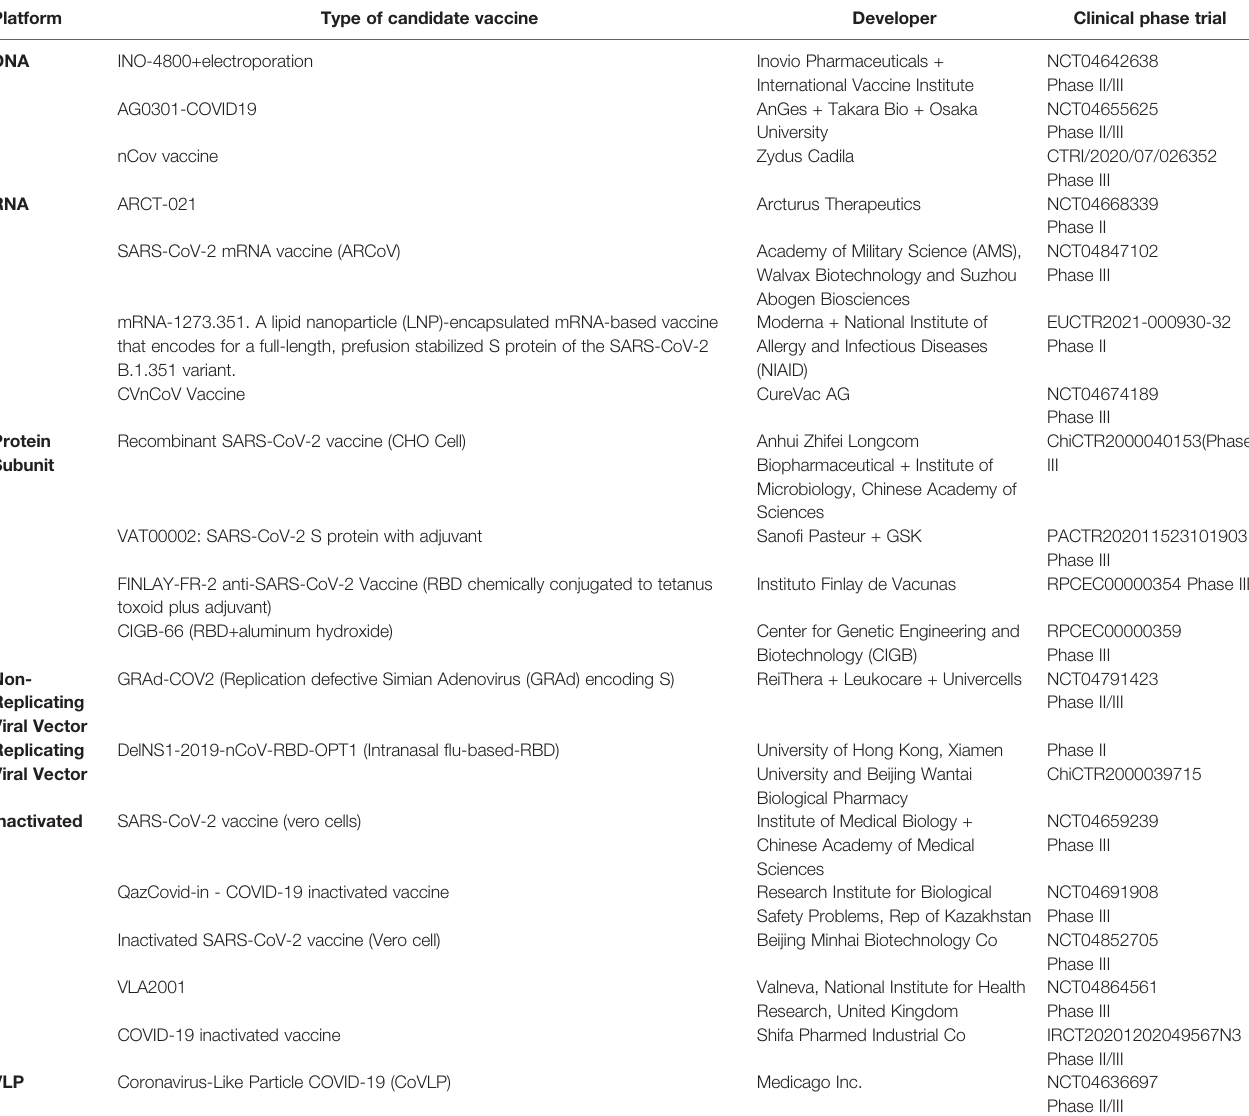
TABLE 1 | Platform of COVID-19 Vaccine.